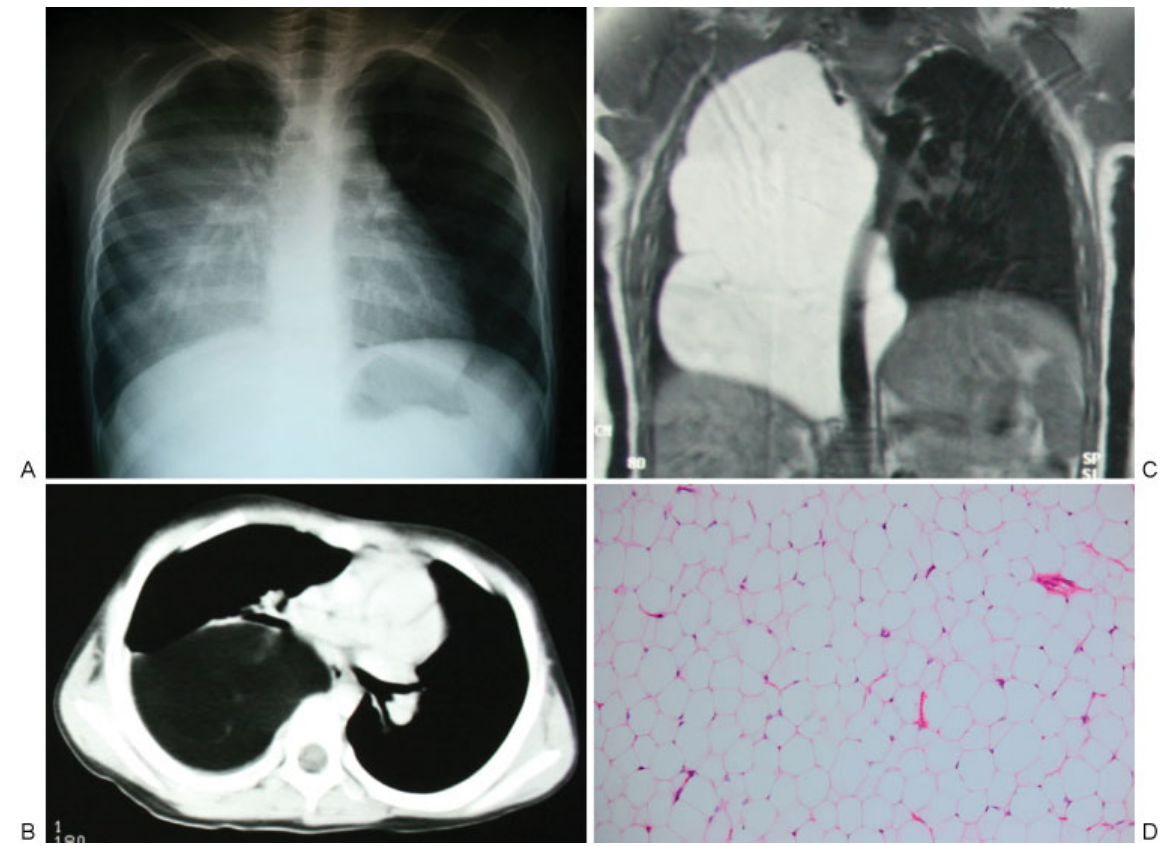
Fig. 1 (a) Chest fi lm showing the mass within the right hemithorax. (b) Computed tomography showing the homogenous mass occupying the right posterior hemithorax, with the heart and mediastinal structures shifted to the left. (c) T1-weighted magnetic resonance imaging of the chest showing the homogenous mass of high intensity, which parallels signal intensity of subcutaneous fat. (d) Histologic view showing mature adipocytes (hematoxylin-eosin, original magni fi cation (cid:1)